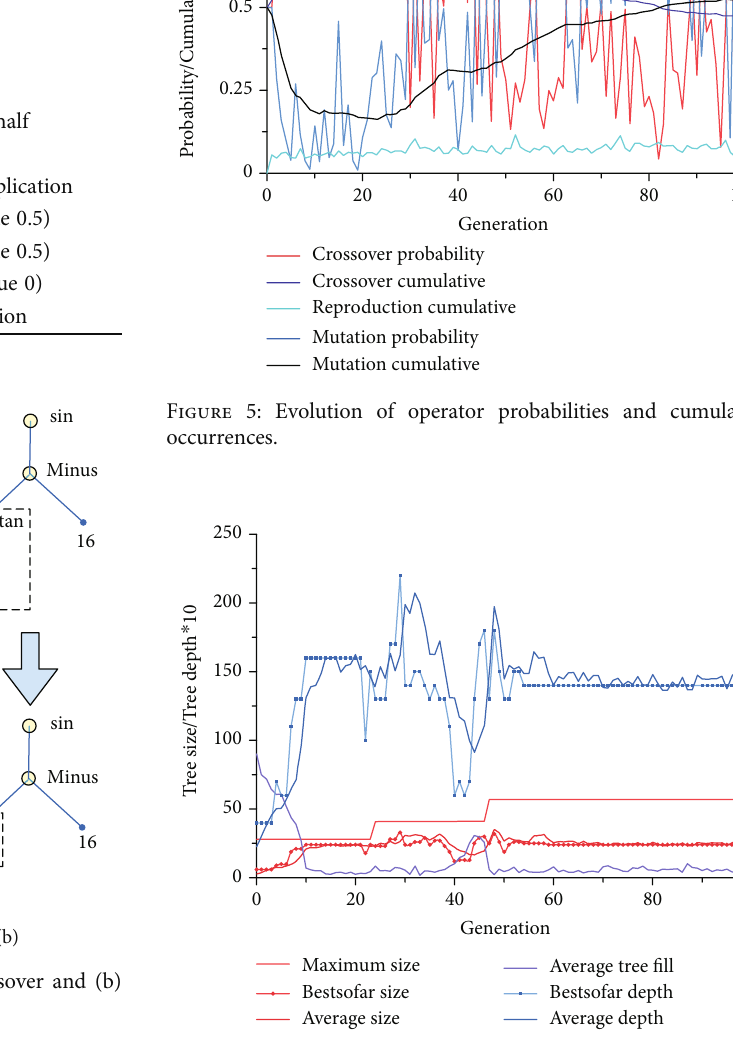
Figure 6: Evolution of tree size and depth in